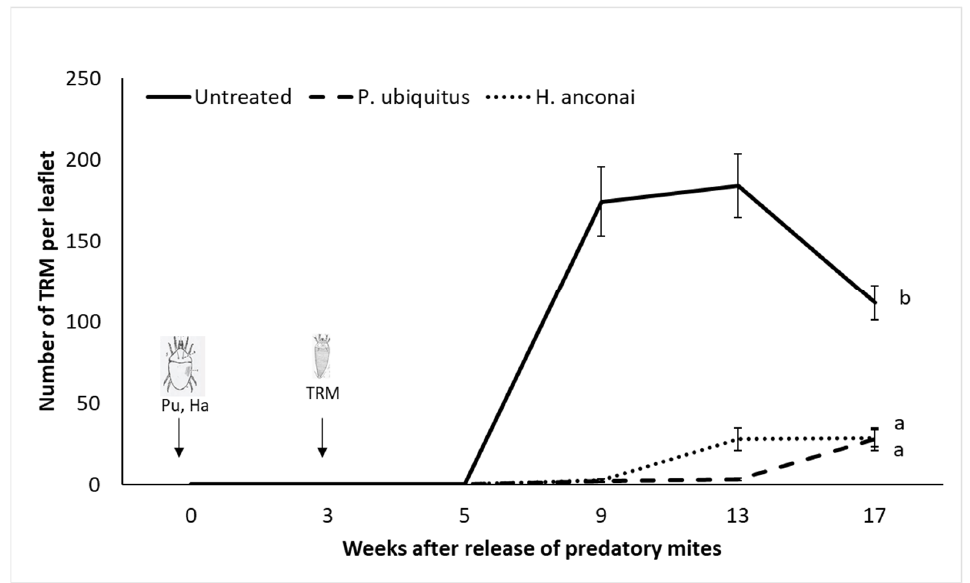
Figure 4. Population dynamics of TRM on tomato plants for 14 weeks. Different letters indicate a significant difference in the number of Aculops lycopersici between the inoculated tomato plants and the control plants (linear mixed-effects models, p < 0.05).